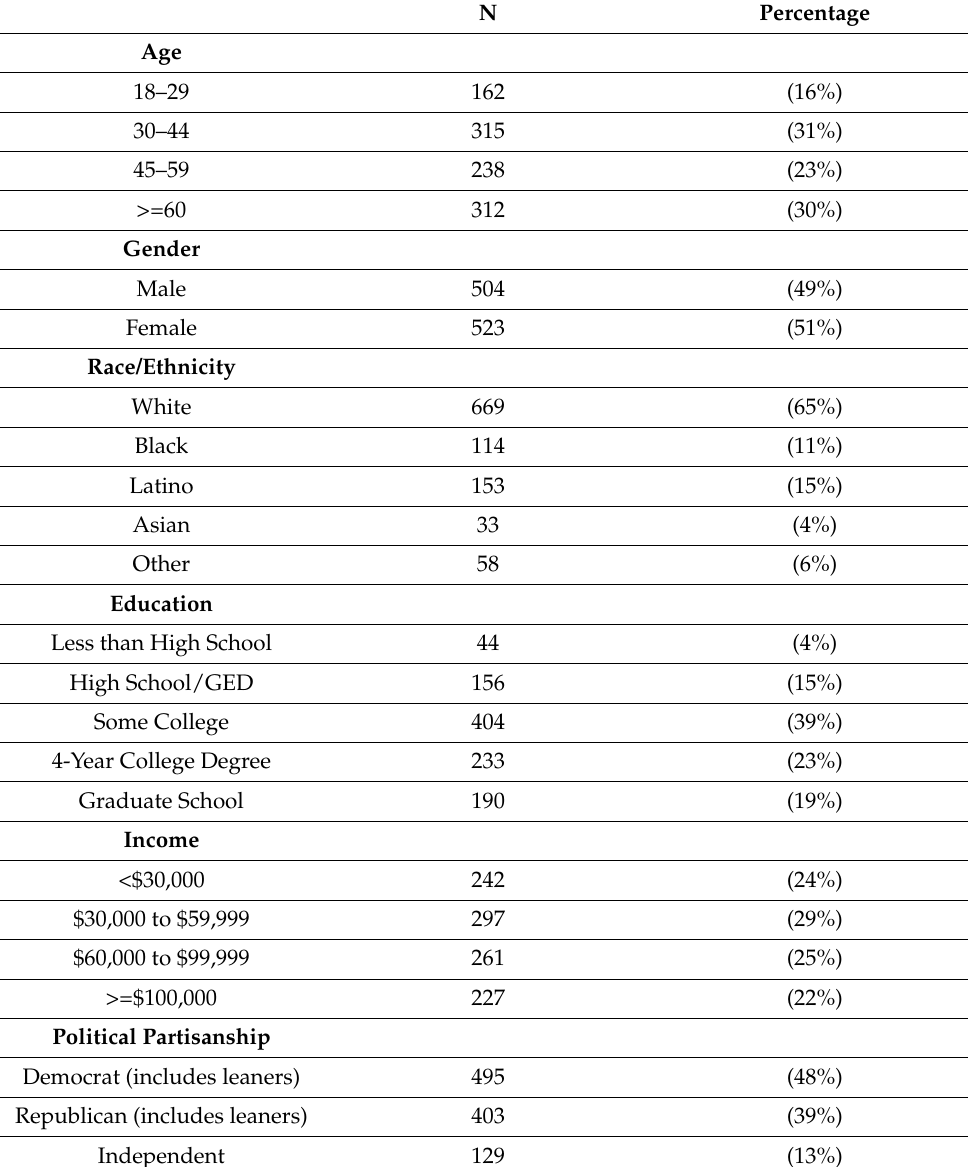
Table 1. Survey sample